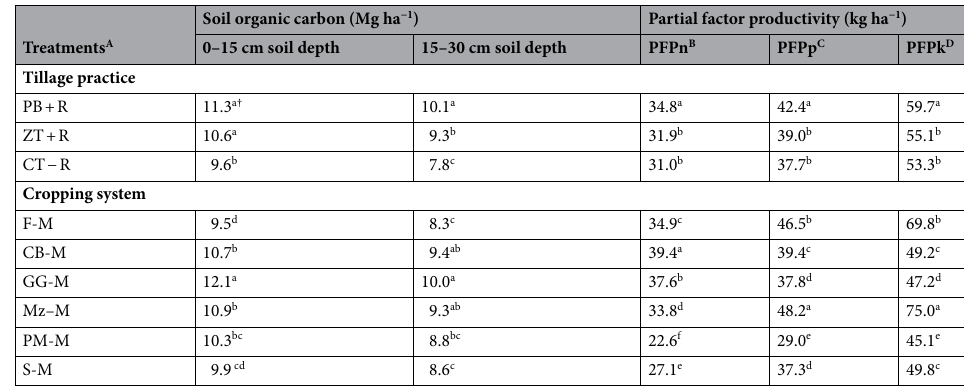
Table 5. Soil organic carbon stock and partial factor productivity of NPK influenced with CA-based Indian mustard systems (3-year mean). † Means followed by a similar lowercase letters within a column are not significantly different at 0.05 level of probability using DMRT. Initial SOC at 0–15 cm—8.8 and at 15–30 cm—7.1 Mg ha −1 . A Refer Table 7 for treatment description. B Partial factor productivity of N. C Partial factor productivity of P. D Partial factor productivity of K.